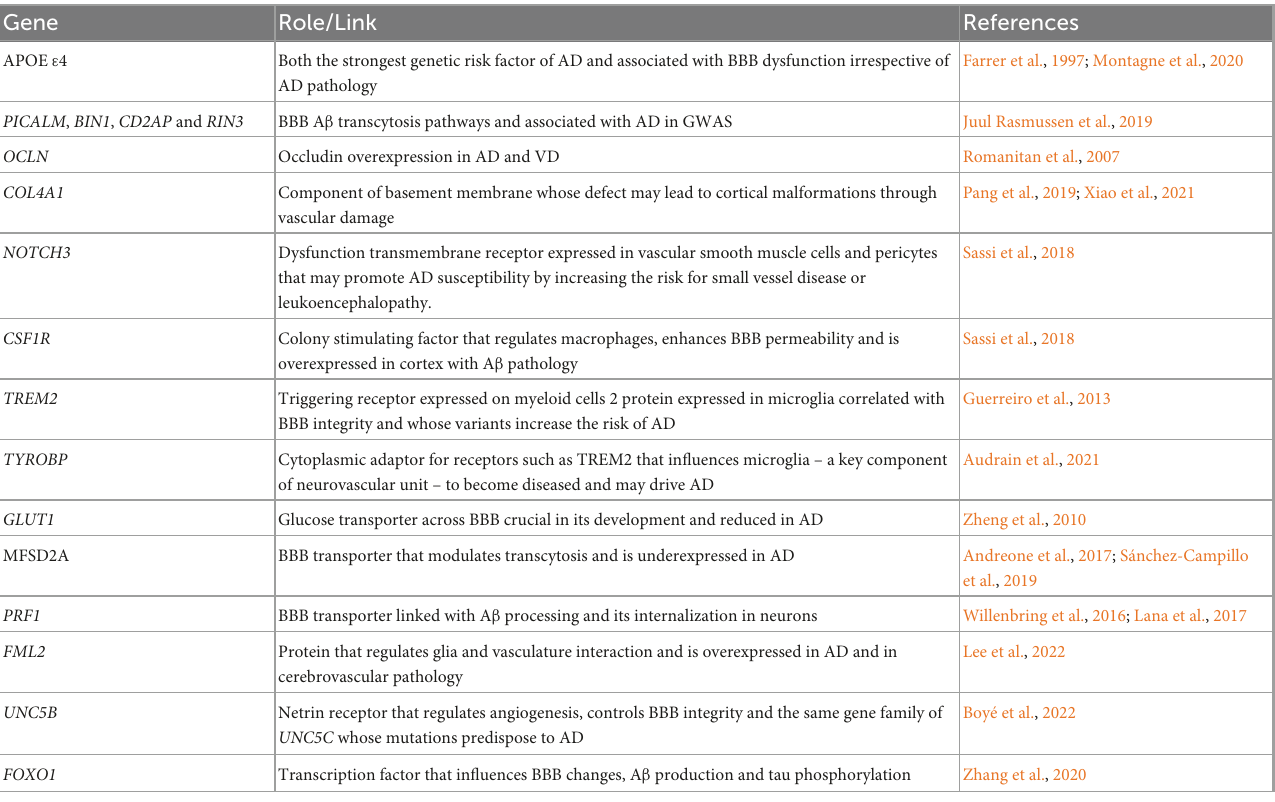
TABLE 2 Genetic links between Alzheimer’s disease and/or cognition and blood-brain barrier dysfunction. Gene